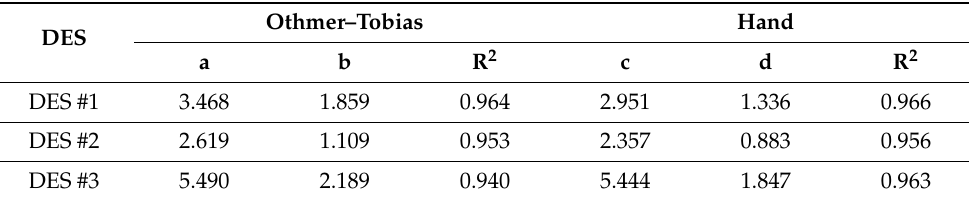
Table 9. Othmer–Tobias and Hand correlations parameters.